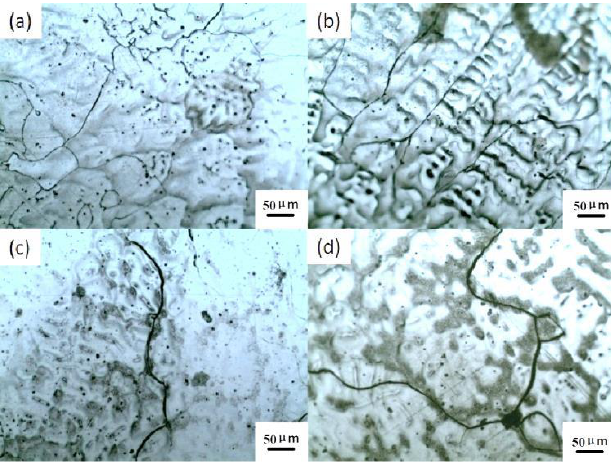
Figure 10. Diagram of profile of tested steel hot compression specimen. ( a ) 1050 °C, ( b ) 1100 °C, ( c ) 1150 °C, ( d ) 1200 °C.